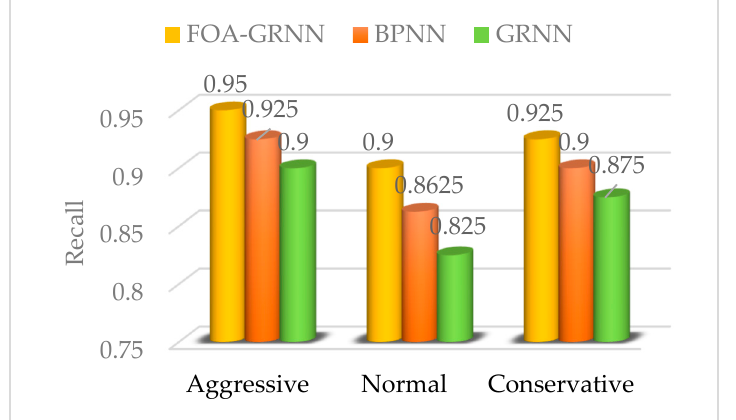
Figure 13. Recall comparison of the FOA-GRNN, BPNN and GRNN identification models.